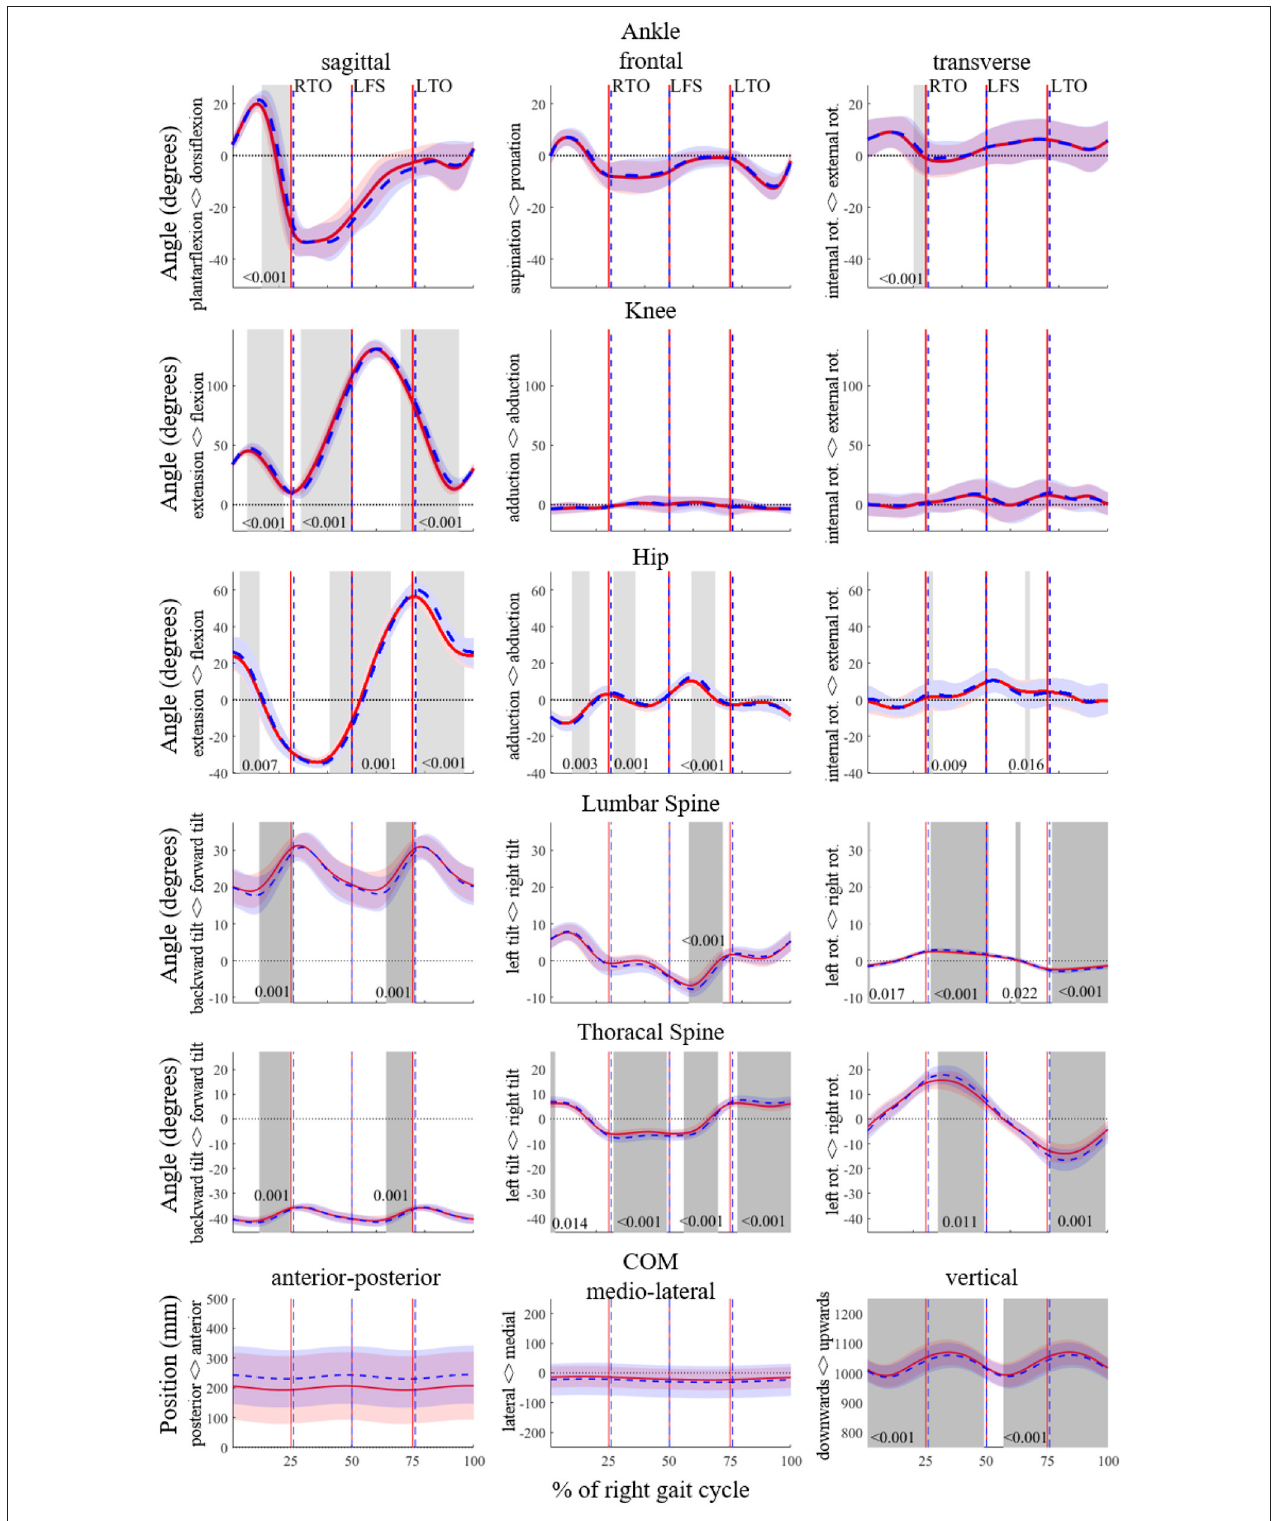
FIGURE 1 | SPM analyses for the angles of the ankle, knee, hip, lumbar spine and thoracic spine in degrees, and of the trajectory of the center of mass (CoM) in mm for the entire running gait cycle of the right leg (from right foot strike to right foot strike) in 3D. The PRE and POST time series data are shown in red and blue, respectively. Significant differences ( p < 0.05) are highlighted with gray areas and corresponding p -values are given. RTO signifies right toe off; LFS, left foot strike; LTO, left toe-off.